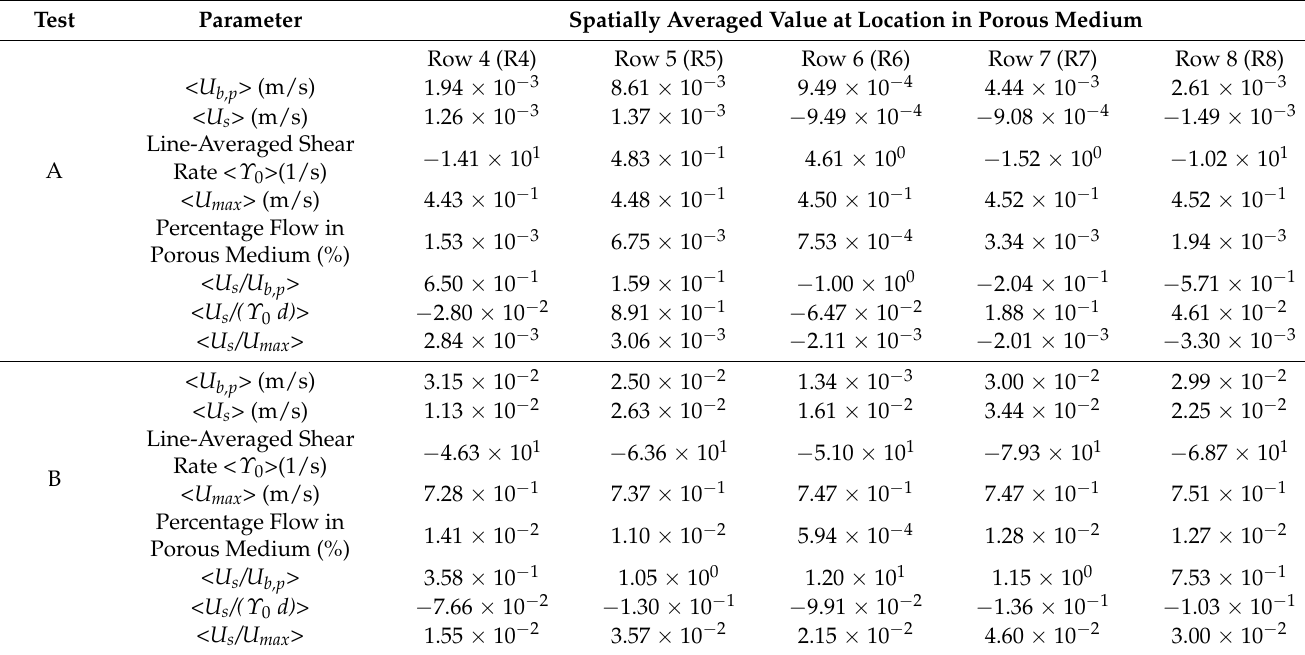
Table 3. Summary results of porous media parameters showing spanwise variation for flow between columns 8 and